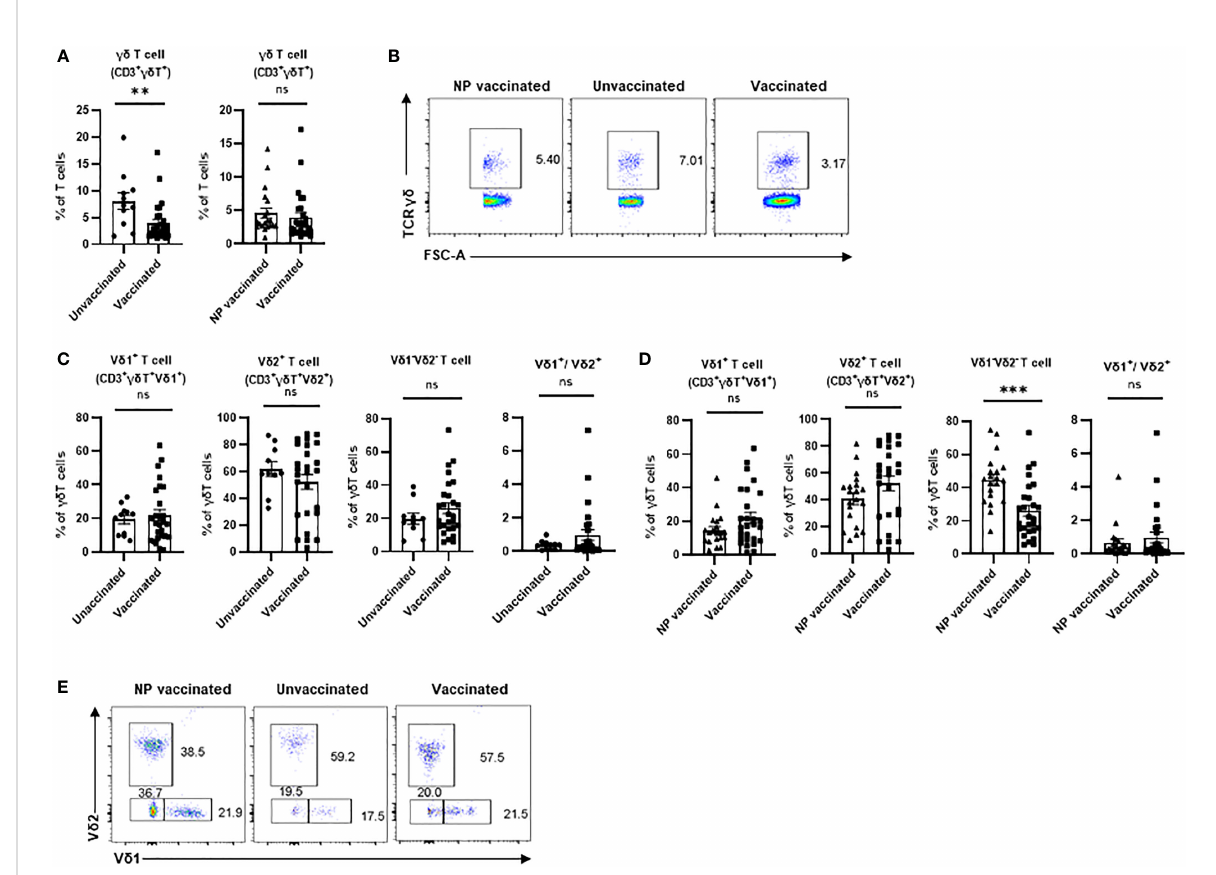
FIGURE 1 Peripheral gd T cells and their subsets in non-pregnant vaccinated women, vaccinated, and unvaccinated pregnant women. Statistical comparison of gd T cell proportions in CD3 + T cells (A, B) Typical fl ow cytometry plots and gating for a CD3 + TCR gd + ;V d 1 + , V d 2 + , and V d 1 - V d 2 - subsets in gd T cells (C, D) , and the V d 1 + /V d 2 + ratio between the vaccinated and unvaccinated pregnant women. (E) Gate from TCR gd + cells,V d 1 + , V d 2 + , and V d 1 - V d 2 - subsets are shown as representative fl ow cytometry plots. ns, no signi fi cance; **P < 0.01. ***P < 0.001. (NP vaccinated, non-pregnant